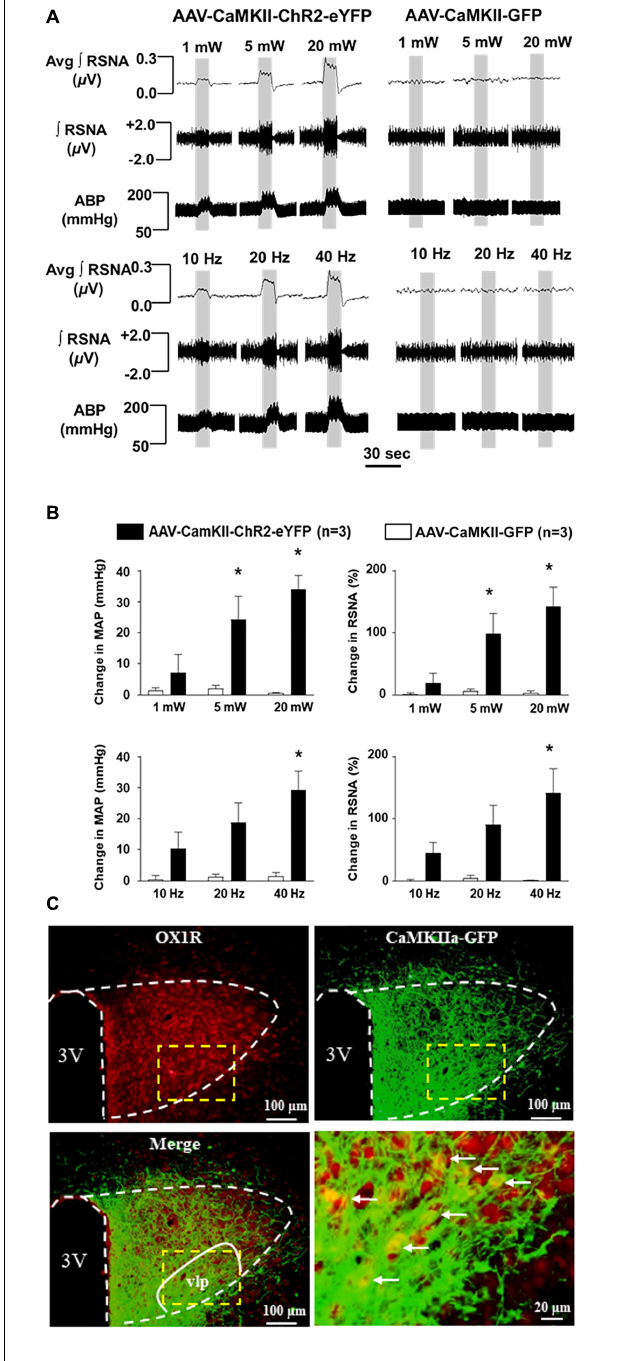
FIGURE 6 | Optogenetic stimulation of CaMKII-expressing neurons in the PVN increases renal sympathetic nerve activity (RSNA) and arterial blood pressure (ABP). (A) Representative traces of RSNA and ABP during 10 sec optogenetic stimulation in the PVN at the intensity of 1, 5, and 20 mW (5 ms pulse duration) in AAV-CaMKII-ChR2-eYFP (left) and control vector AAV-GFP (right) injected rats (Top panels); and representative traces of RSNA and ABP during 10 sec optogenetic stimulation in the PVN at the frequency of 10, 20, and 40 Hz (5-ms pulse duration and 20 mW) in AAV-CaMKII-ChR2-eYFP (left) and AAV-GFP (right) injected rats (Low panel). (B) Population data showing